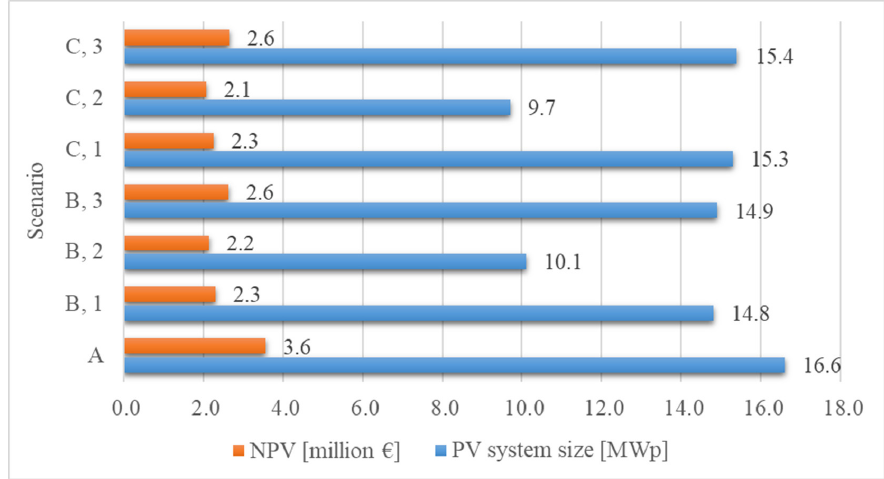
Figure 10. PV system sizes and the NPV figures related to them by scenario.